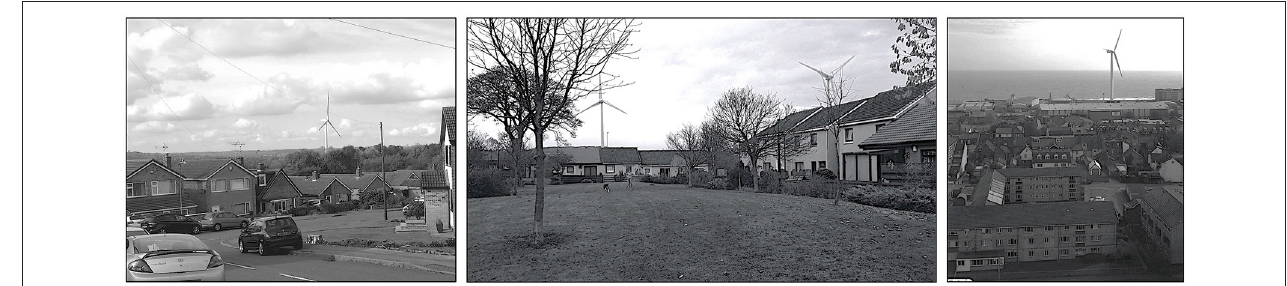
FIGURE 1 | Photos of three study sites (left: Site A with wind turbine (WT) in the field; middle: Site B with WTs on the industrial site; right: Site C with WT at the seaside; photos were taken by the